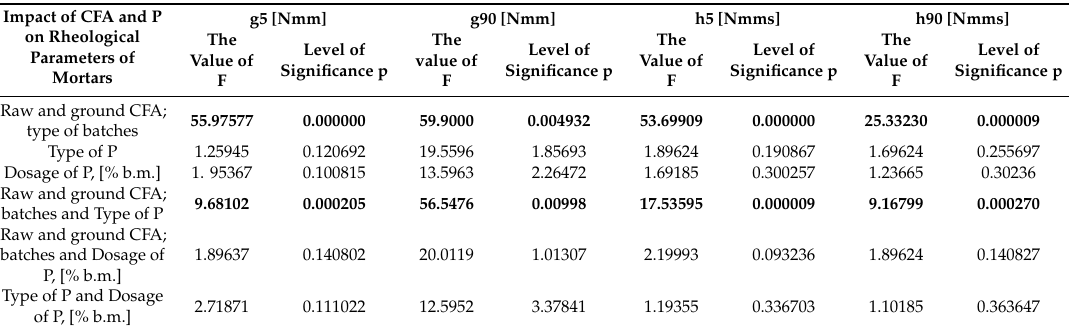
Table 9. Analysis of Variance (ANOVA). One-dimensional significance tests for rheological parameters of mortar with P.